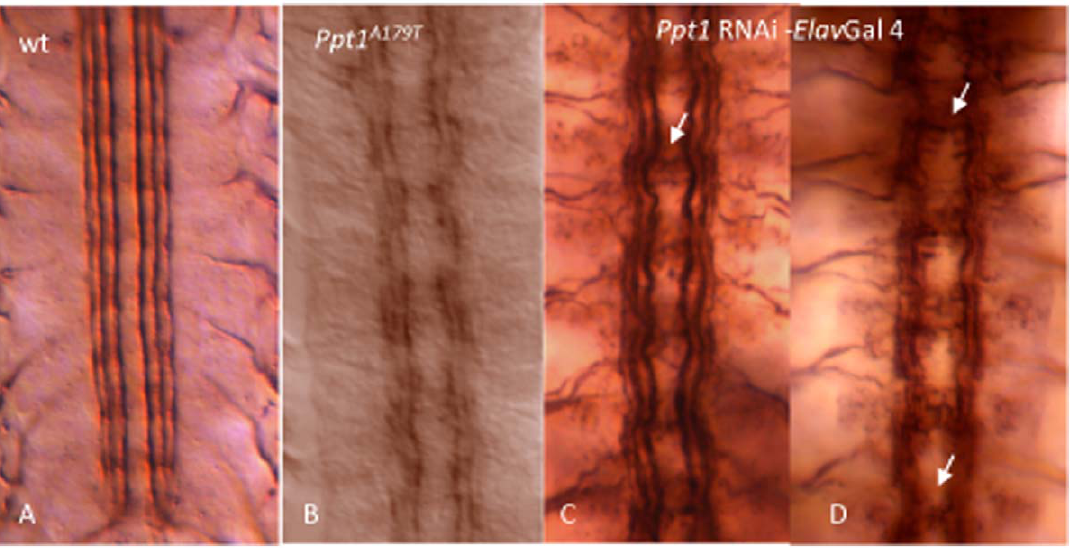
Figure 5. Mutant Ppt1 and Ppt1 RNAi knock-down in neurons result in defective axon tracts in the developing CNS. In all panels, S17 embryos were stained with 1D4 antibody. (A) FASII is expressed in three longitudinal connectives at this stage. (B) Ppt1 A179T embryos exhibit discontinuous and frayed longitudinal connectives. (C, D) Ppt1 RNAi expression under the control of elav gal4 driver results in a range of axon guidance phenotype including wavy bundles with some faulty axon crossing over the midline (arrow in C); and disorganized and/or broken connectives, and fused commissures (arrows in D). Anterior, up.